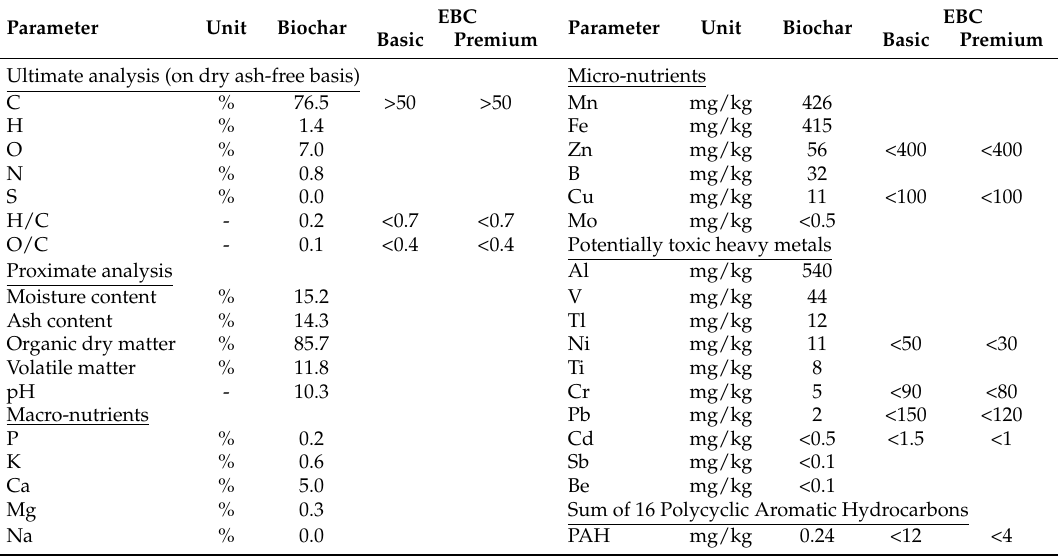
Table 3. Biochar properties [23] and thresholds of the European Biochar Certificate (EBC) [24]. Parameter